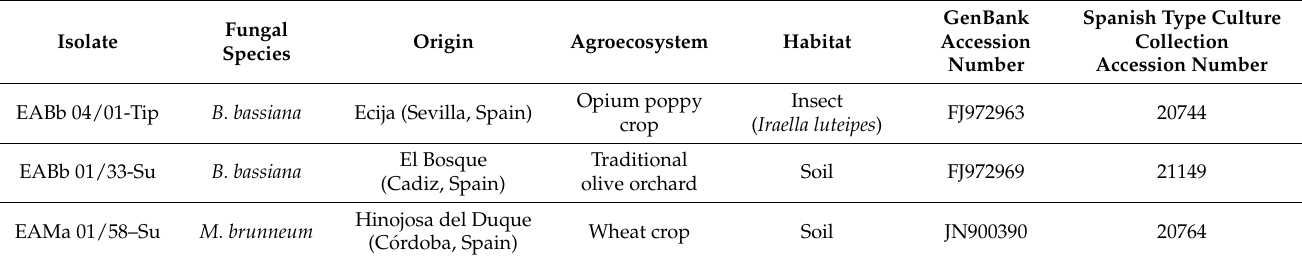
Table 1. Fungal isolates used in